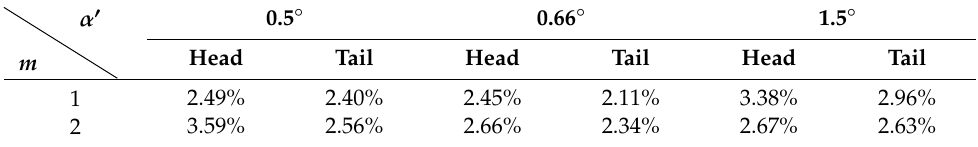
Table 4. Actual vs. theoretical current average absolute error list at di ff erent α (cid:48)